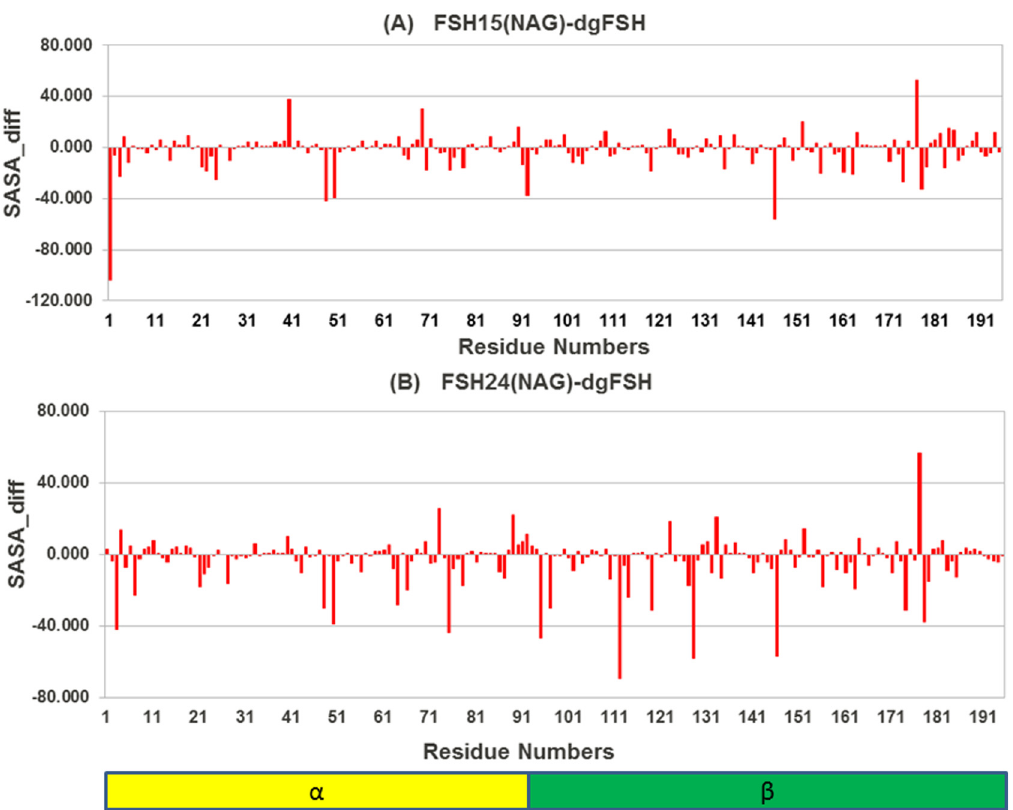
Fig 12. Difference in Solvent Accessible Surface Area (SASA) for FSH 15 (NAG) and FSH 24 (NAG) relative to de-glycosylated